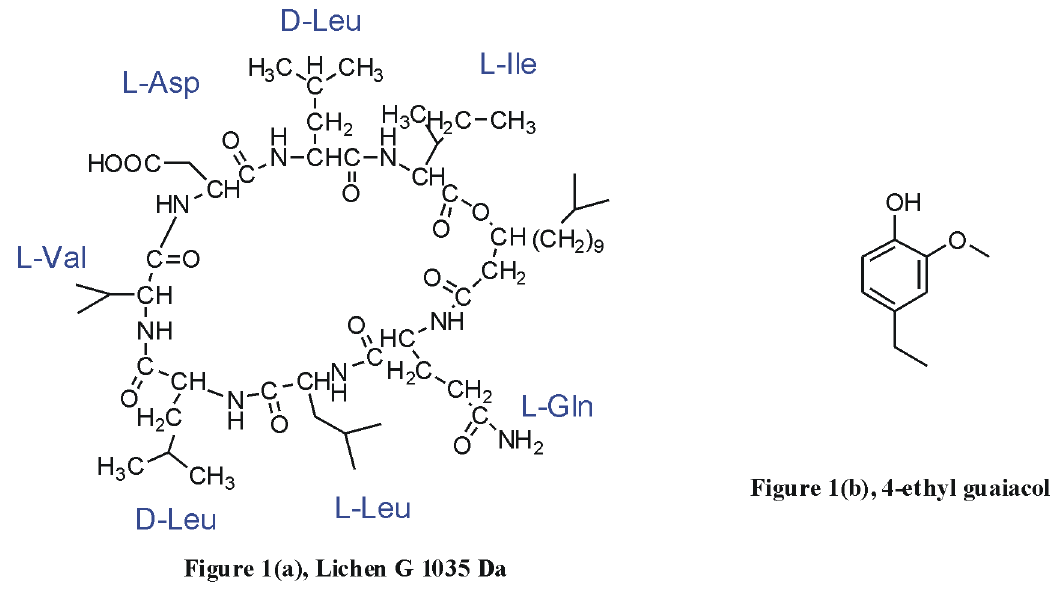
Figure 1. (a) lichensins G 1035 Da, (b) 4-ethyl guaiacol.